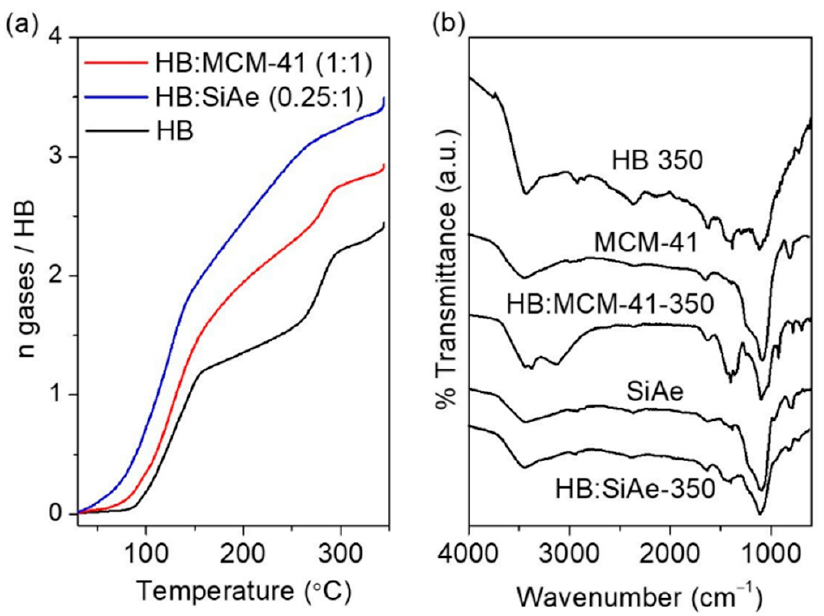
Figure 8. ( a ) Volumetric release measurement of bulk HB, HB:MCM-41 (1:1) and HB: Si-Ae (0.25:1) at a heating rate of 5 °C min − 1 . ( b ) FTIR characterization of the samples collected after decomposition.